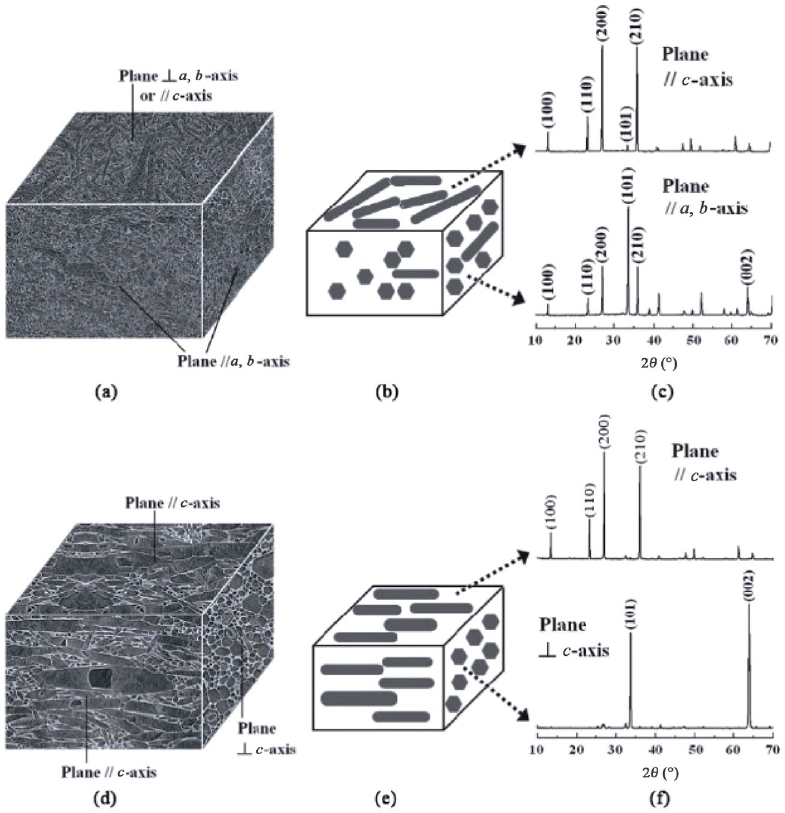
Fig. 27 Microstructures and XRD patterns of the a , b -axis oriented and c -axis oriented β-Si 3 N 4 specimens: (a, d) actual microstructures; (b, e) schematic diagrams; (c, f) XRD patterns. Reproduced with permission from Ref. [23], © National Institute for Materials Science